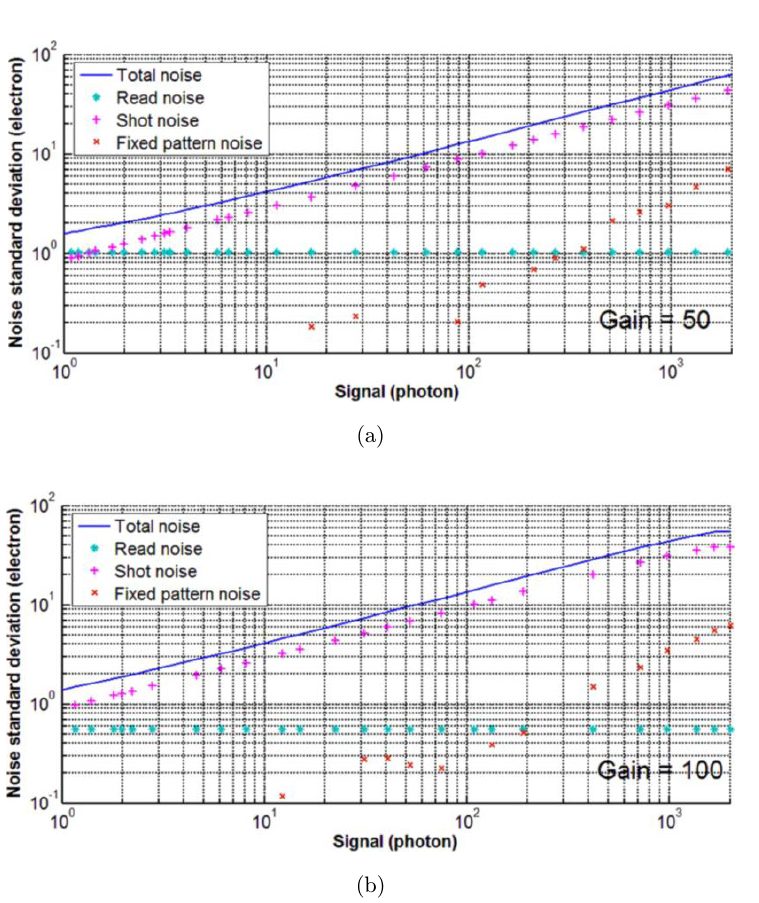
Fig. 4. EM gain in°uence on the imaging performance of the same Andor iXon 897 EMCCD camera. (a) Gain ¼ 50, (b) Gain ¼ 100 (b), (c) Gain ¼ 200. (d) Theoretical and experimental rSNR curves for di®erent EM gains. The inserted ¯gure in (d) is an enlarged view of the region marked by the red rectangle in (d). The measurement is performed with a narrow band light centered 698 nm. Note that the read noise values from (a) to (c) decrease from 1.03 e (cid:1) (a) to 0.56 e (cid:1) (b), and then further to 0.34 e (cid:1) (c), and that the rSNR of a hypothetical QE-limited camera equals to the square root of the QE of that